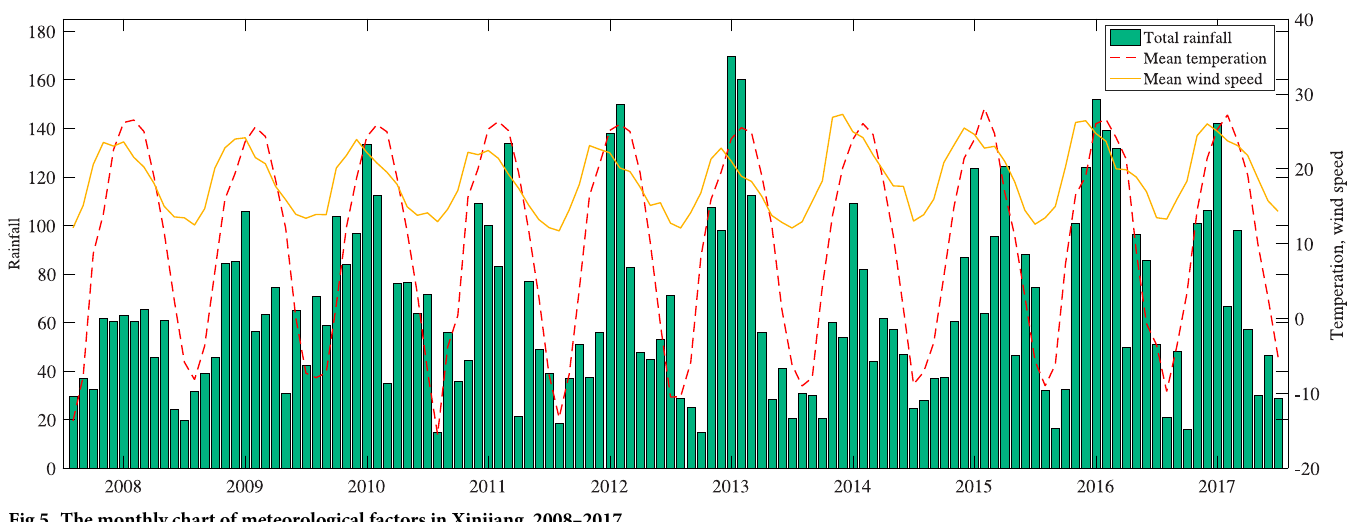
Fig 5. The monthly chart of meteorological factors in Xinjiang, 2008–2017. https://doi.org/10.1371/journal.pone.0254223.g005 Table 3. Spearman correlation between lagging factors and the confirmed